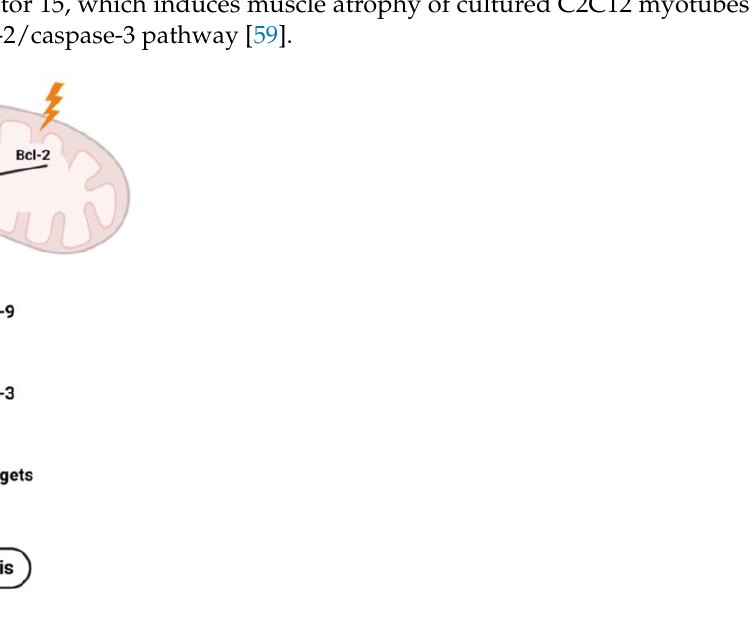
Figure 2. Disrupted Bax-to-Bcl-2 ratio in mitochondria of C2C12 myoblasts coculture with CT26 colon carcinoma cells. Bcl-2, B-cell lymphoma 2; Bax, Bcl-2-associated X protein. Created with Biorender.com (accessed on 11 October 2022) .